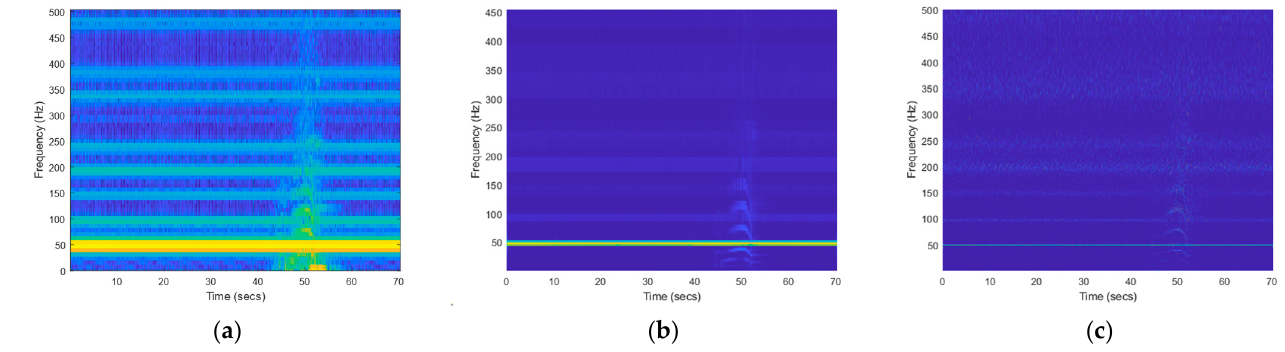
Figure 7. Comparison of three different time-frequency maps; ( a – c ) are time-frequency diagrams for STFT, CWT, and SSWT.